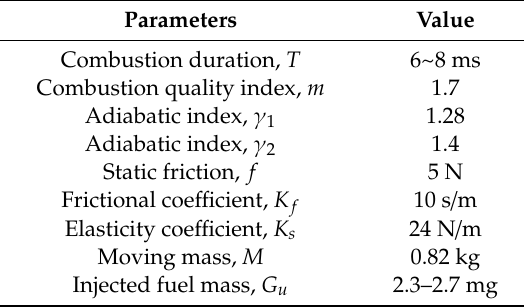
Figure 12. Simulation model of the FPEG. Table 2. The initial simulation parameters.